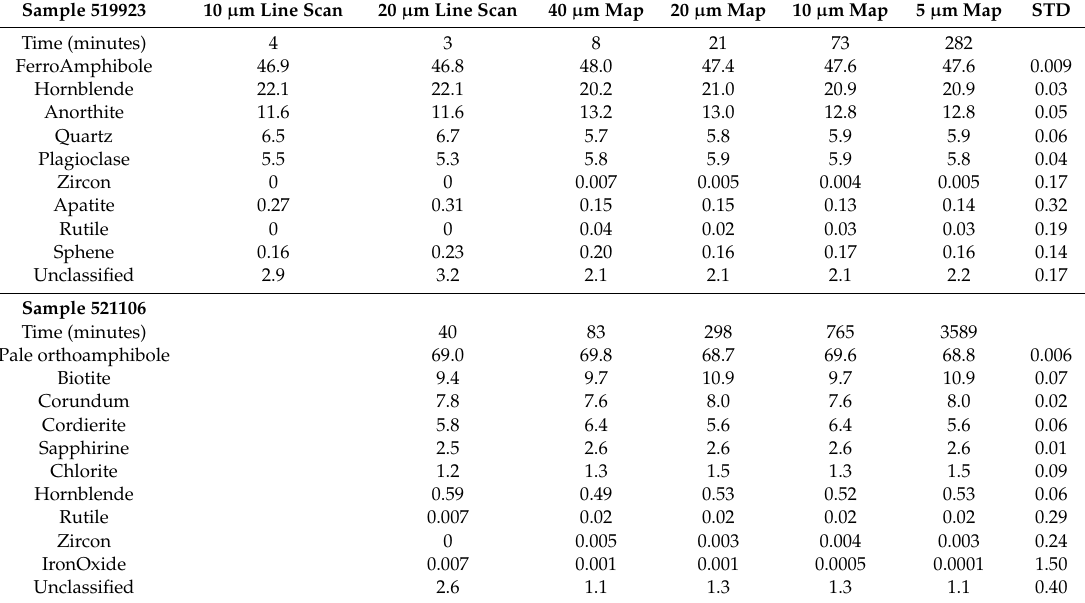
Table 3. Comparison between most abundant and selected other minerals between the di ff erent analysis methods in area % for di ff erent step sizes in line scanning and mapping. STD = standard